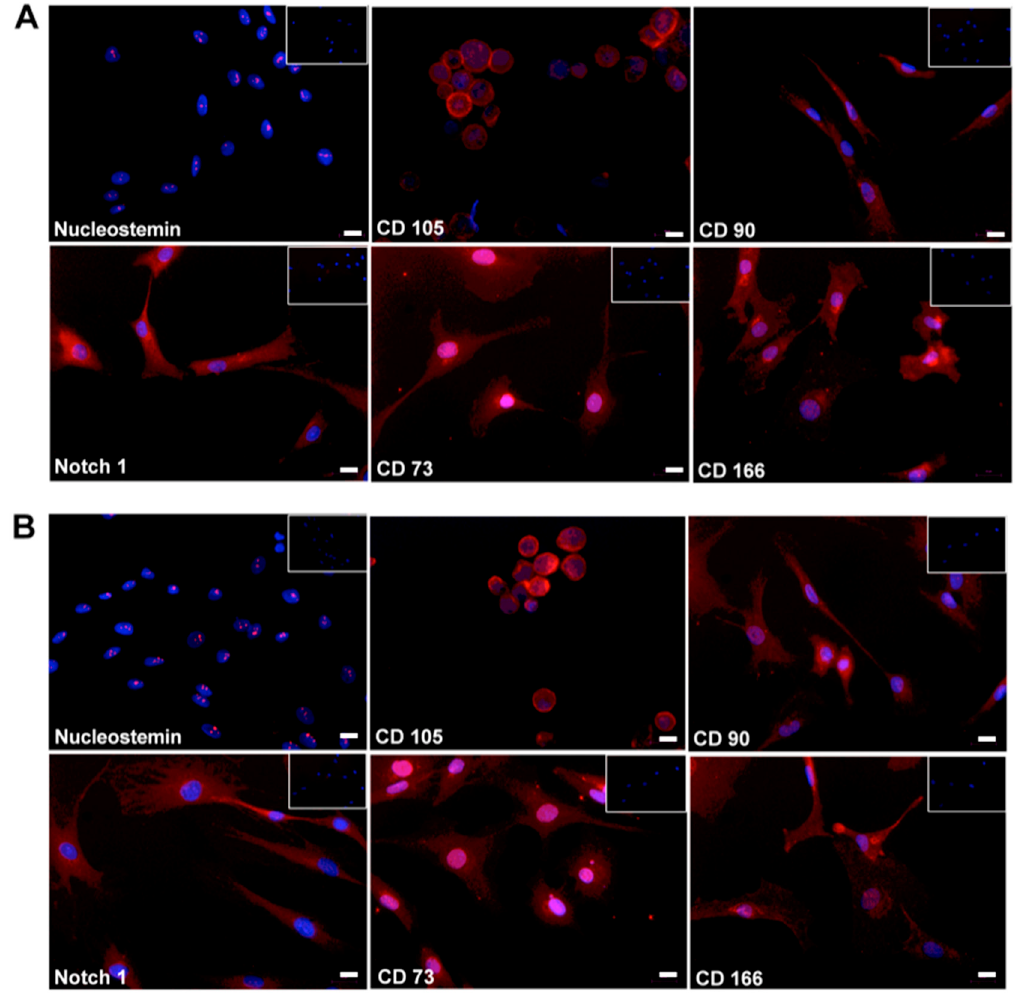
Figure 5. Protein expression of MSC markers in Mild and severe OA-derived cells at D14 (scale bar 20 µm). Immunofluorescence of Nucleostemin, CD105, CD166, CD73, CD90 and Notch 1 in proliferated cells (D14) isolated from areas of Mild OA ( A ) and severe OA ( B ). Markers of interest-RE staining (Red), contra staining DAPI (blue), and Isotype control + DAPI-left corner of each image.